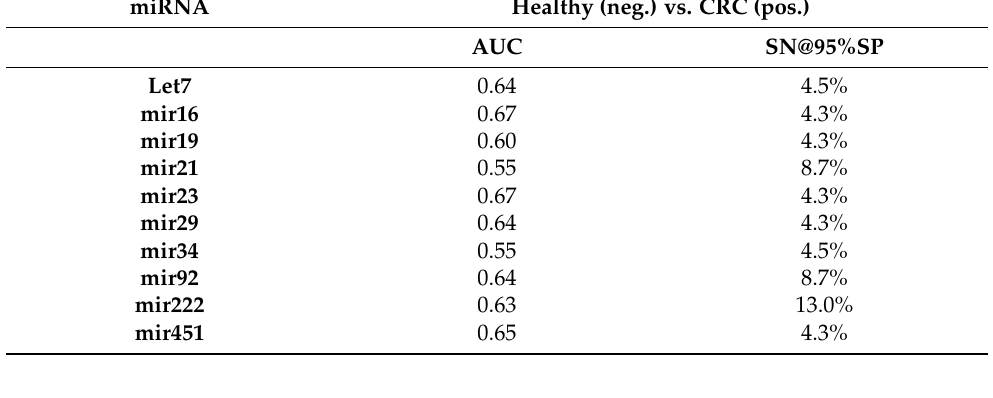
Table 3. Areas under the curve (AUC) and sensitivities (SN) at 95% specificity (SP) for the different miRNAs in the exosomal compartment. Comparisons are between healthy and CRC patients. miRNA Healthy (neg.) vs. CRC (pos.) AUC